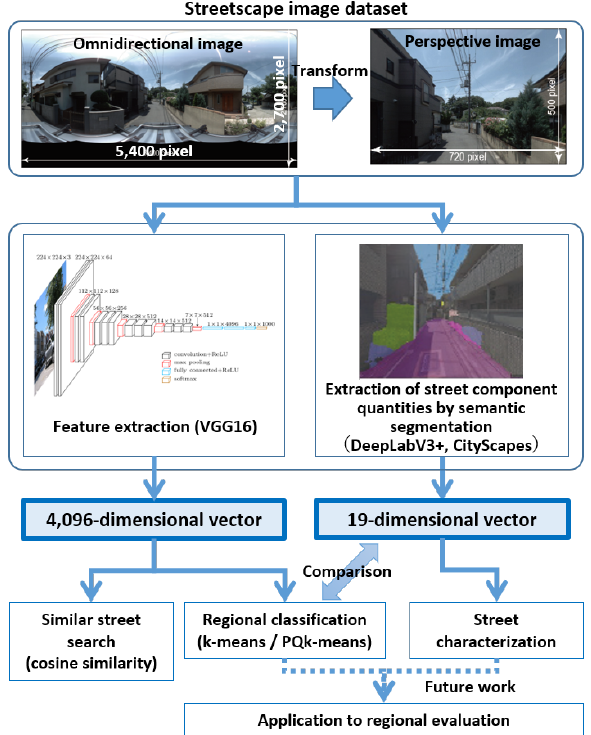
Figure 1. Overview of research process in this